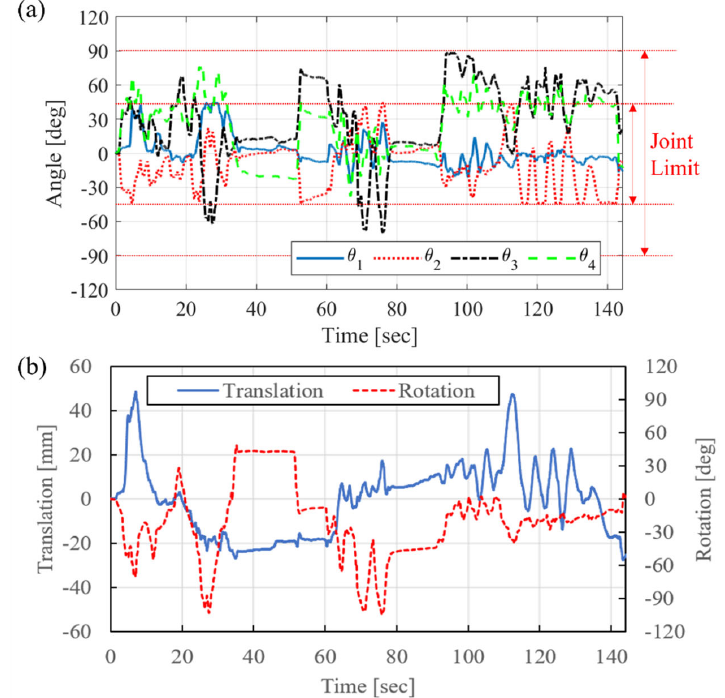
Figure 12. Actuation value for the desired six-DoF motion from the optimization path generator: ( a ) joint angles of robot arm; ( b ) translation stroke and rotation angle of the whole body.